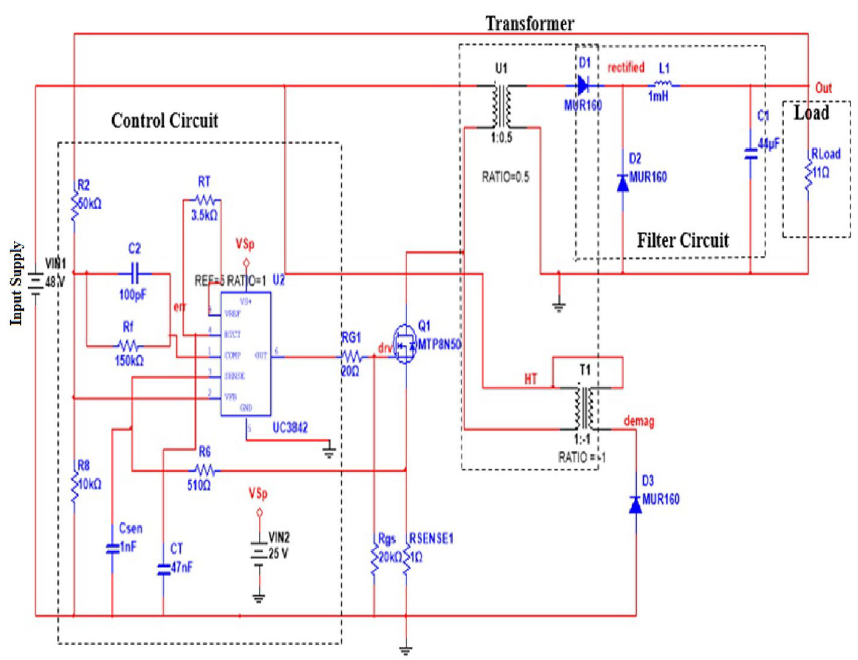
Figure 4. MultiSim simulation circuit of forward